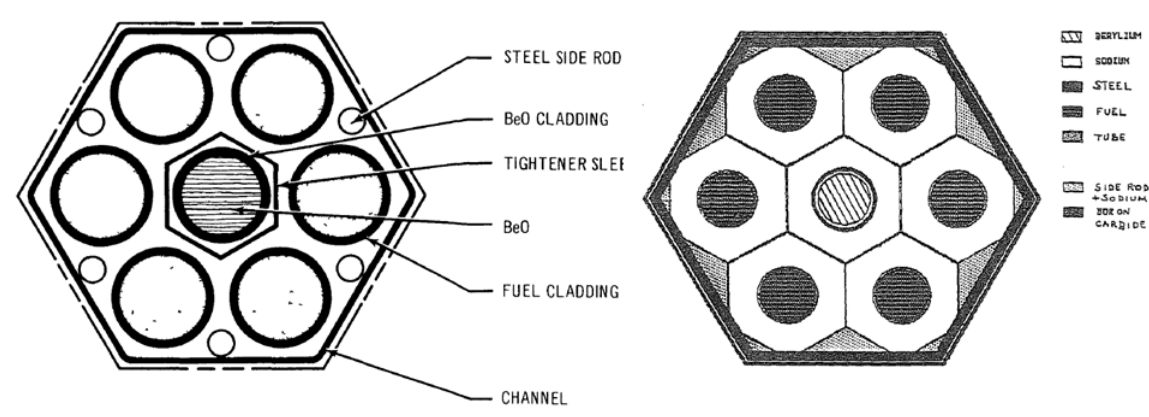
Figure 1. SEFOR Core I fuel assembly layout (left) & its representation in ECCO